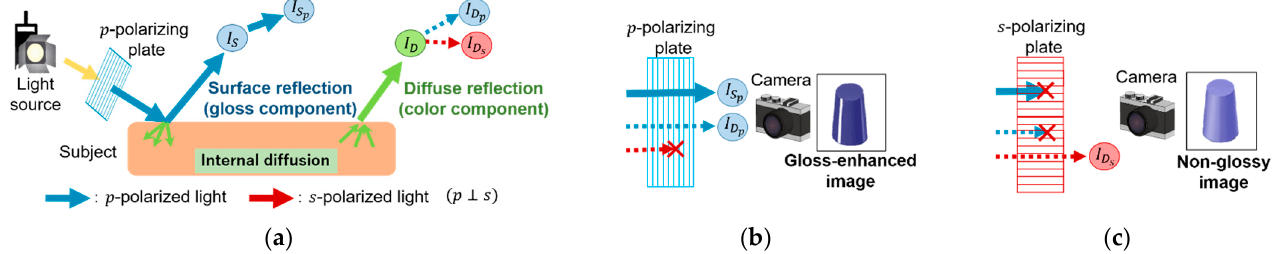
Figure 1. Acquisition of surface and internal reflection using polarizing plate. ( a ) Polarization component of surface reflection and diffuse reflection; ( b ) Taking a gloss-enhanced image; ( c ) Taking a non-glossy image.